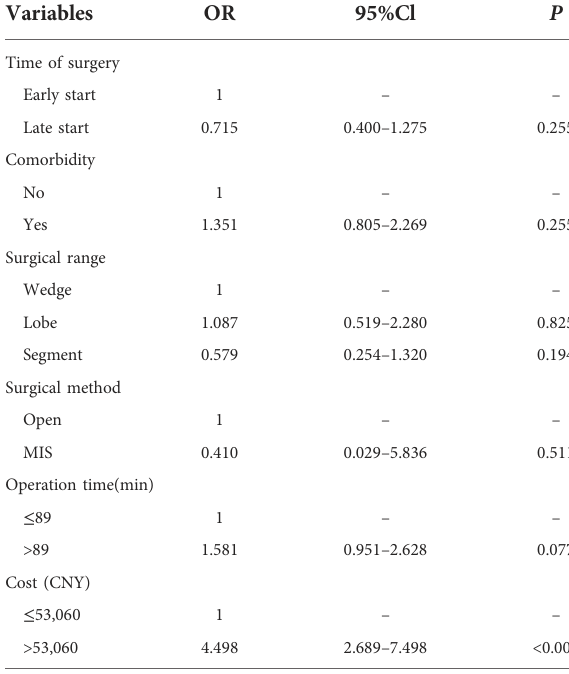
TABLE 3 Multivariable logistic regression analysis of postoperative hospital duration.